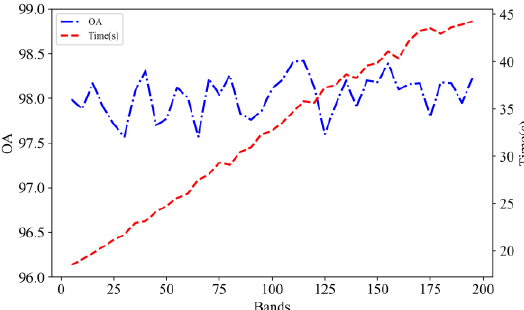
Figure 5. Overall accuracy and training time of DGCNet with change of the